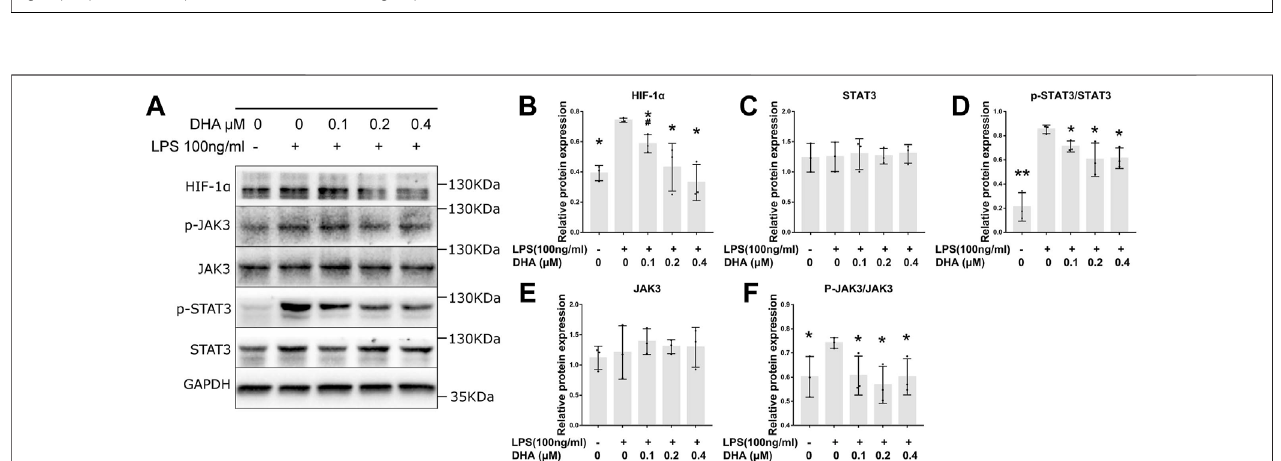
FIGURE4| DHAtreatmentinhibited theHIF-1 α andJAK3/STAT3signaling pathway inmacrophageswithLPSstimulation. (A – F) The expressionofHIF-1 α , JAK3, p-JAK3, STAT3,and p-STAT3at 24 hafter incubation with orwithoutLPS(100 ng/ml)and DHA (0.1,0.2, and 0.4 μ M).* p < 0.05vs. themodel group. # p < 0.05vs. the control